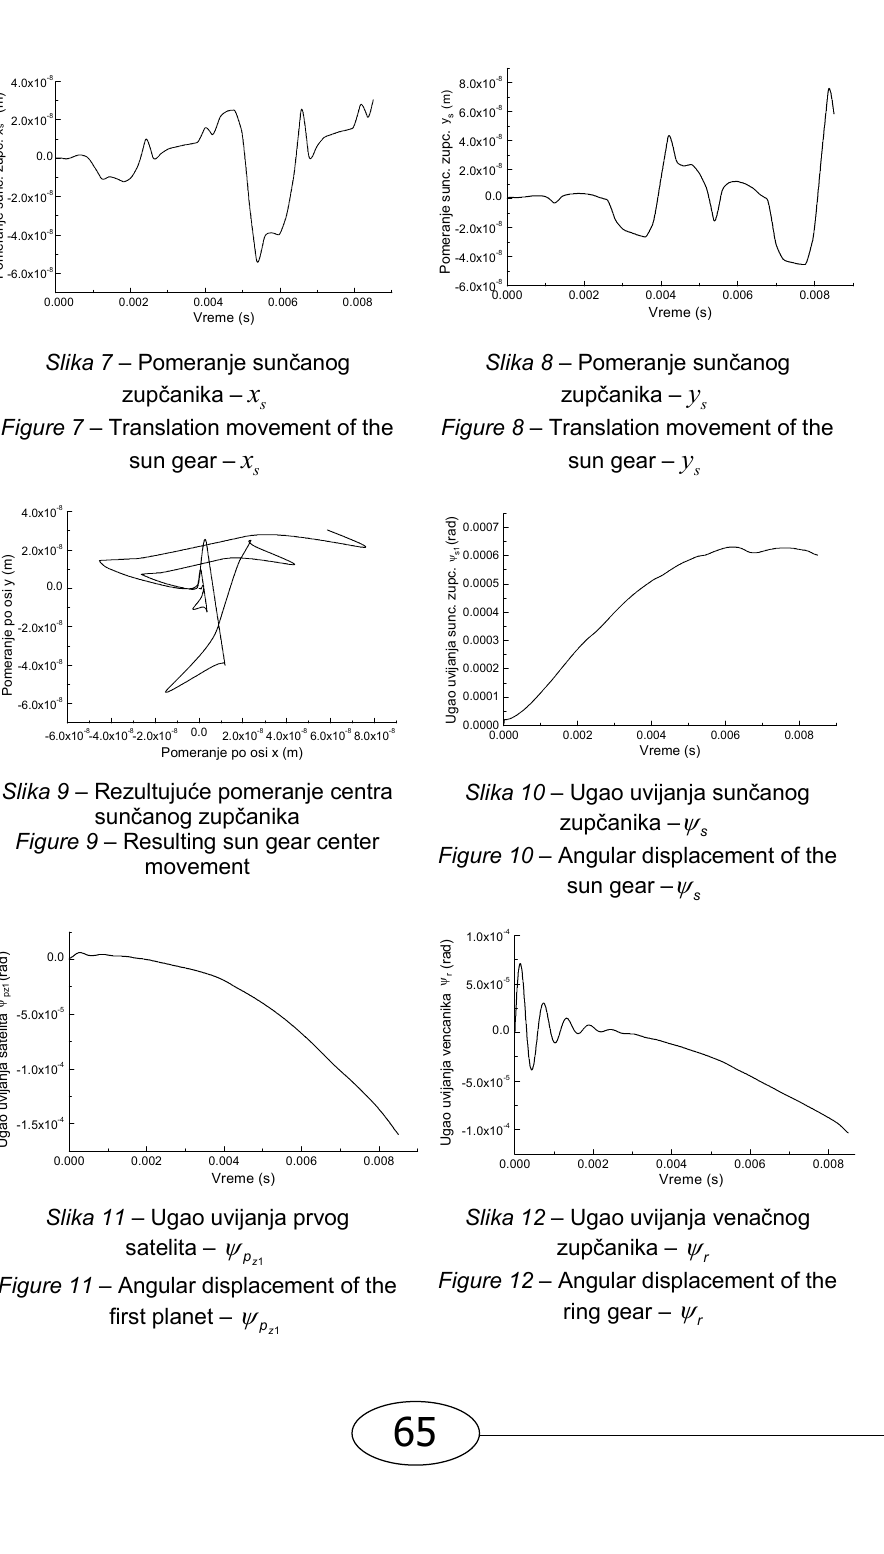
Slika 12 – Ugao uvijanja vena č nog Figure 12 – Angular displacement of the ring gear